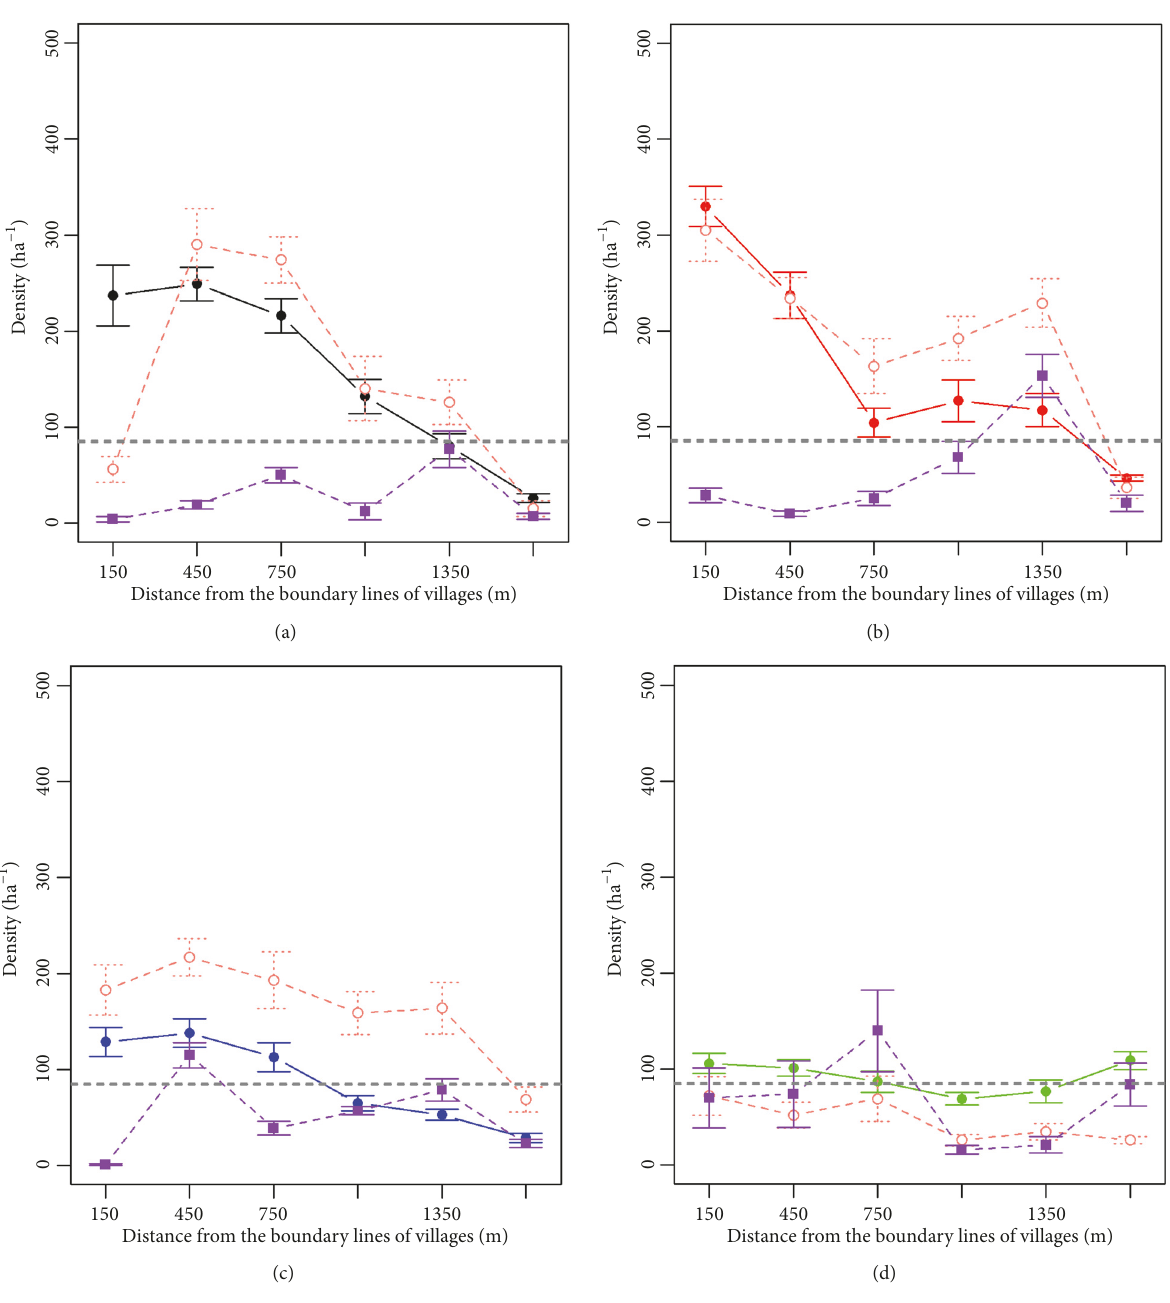
Figure 4: Density (stems ha −1 ) of Shorea robusta (categorized as groups under saplings, poles, and trees) plotted against the distance from the village boundary lines. (a) Janajagaran BZCF, (b) Musharni Mai BZCF, (c) Radha Krishna BZCF, and (d) Parsa Wildlife Reserve. Solid lines in the figure indicate the density of the trees. Salmon colored dotted lines show the density of poles, and purple colored dotted lines show the density of saplings. The vertical lines are standard error bars. The horizontal lines are the reference density lines for the maximum number of mature trees (85 stems ha −1 ) that 1 ha plot can